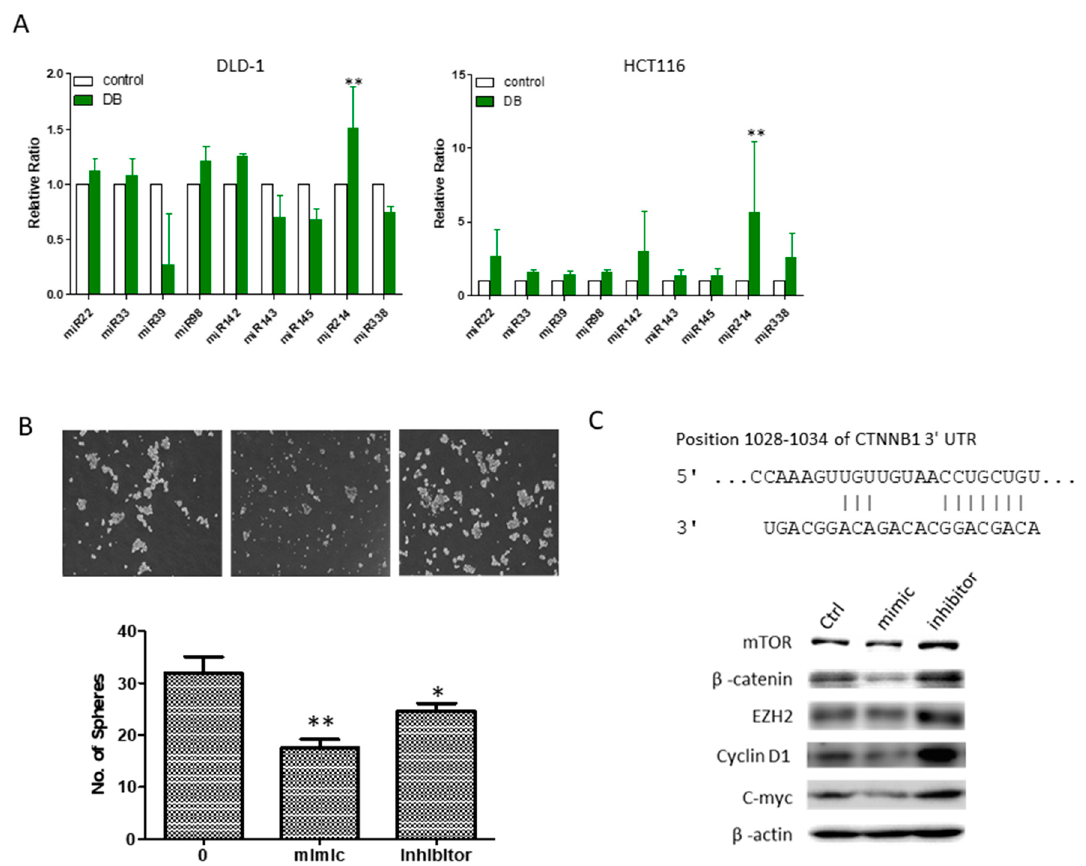
Figure 6. DB treatment was associated with an elevated miR-214. ( A ) Profiling of microRNA expression pattern in DB-treated colon cancer cells. DB treatment led to a significantly increased miR-214 level in both HCT116 and DLD-1 cells. ( B ) Increased miR-214 expression by miR-214 mimic was associated with the suppression of the generation of HCT-116 tumor spheres, while the miR-214 inhibitor reversed the suppressive effect. ( C ) The potential 3 ′ UTR site of CTNNB1 for miR-214 binding was detected using TargetScan software. Western blot analysis showed that miR-214 mimic treatment led to a decreased expression of mTOR, β -catenin, EZH2, cyclin D1, and c-Myc, whereas an increased expression of these markers was found in HCT-116 cells treated with the miR-214 inhibitor. (* p ≤ 0.05; ** p ≤ 0.01).